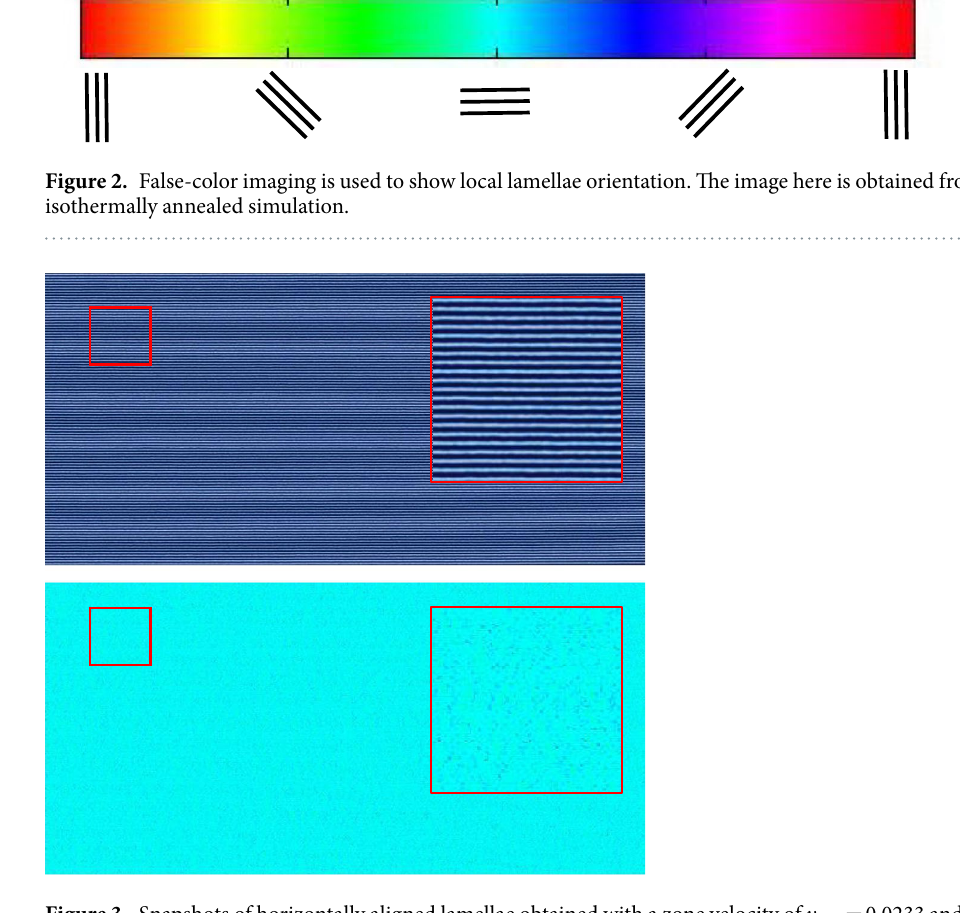
additional details), four distinct regions present themselves within the data. The mean orientation values are plotted and the standard error of the mean is represented by the shaded areas around each line.